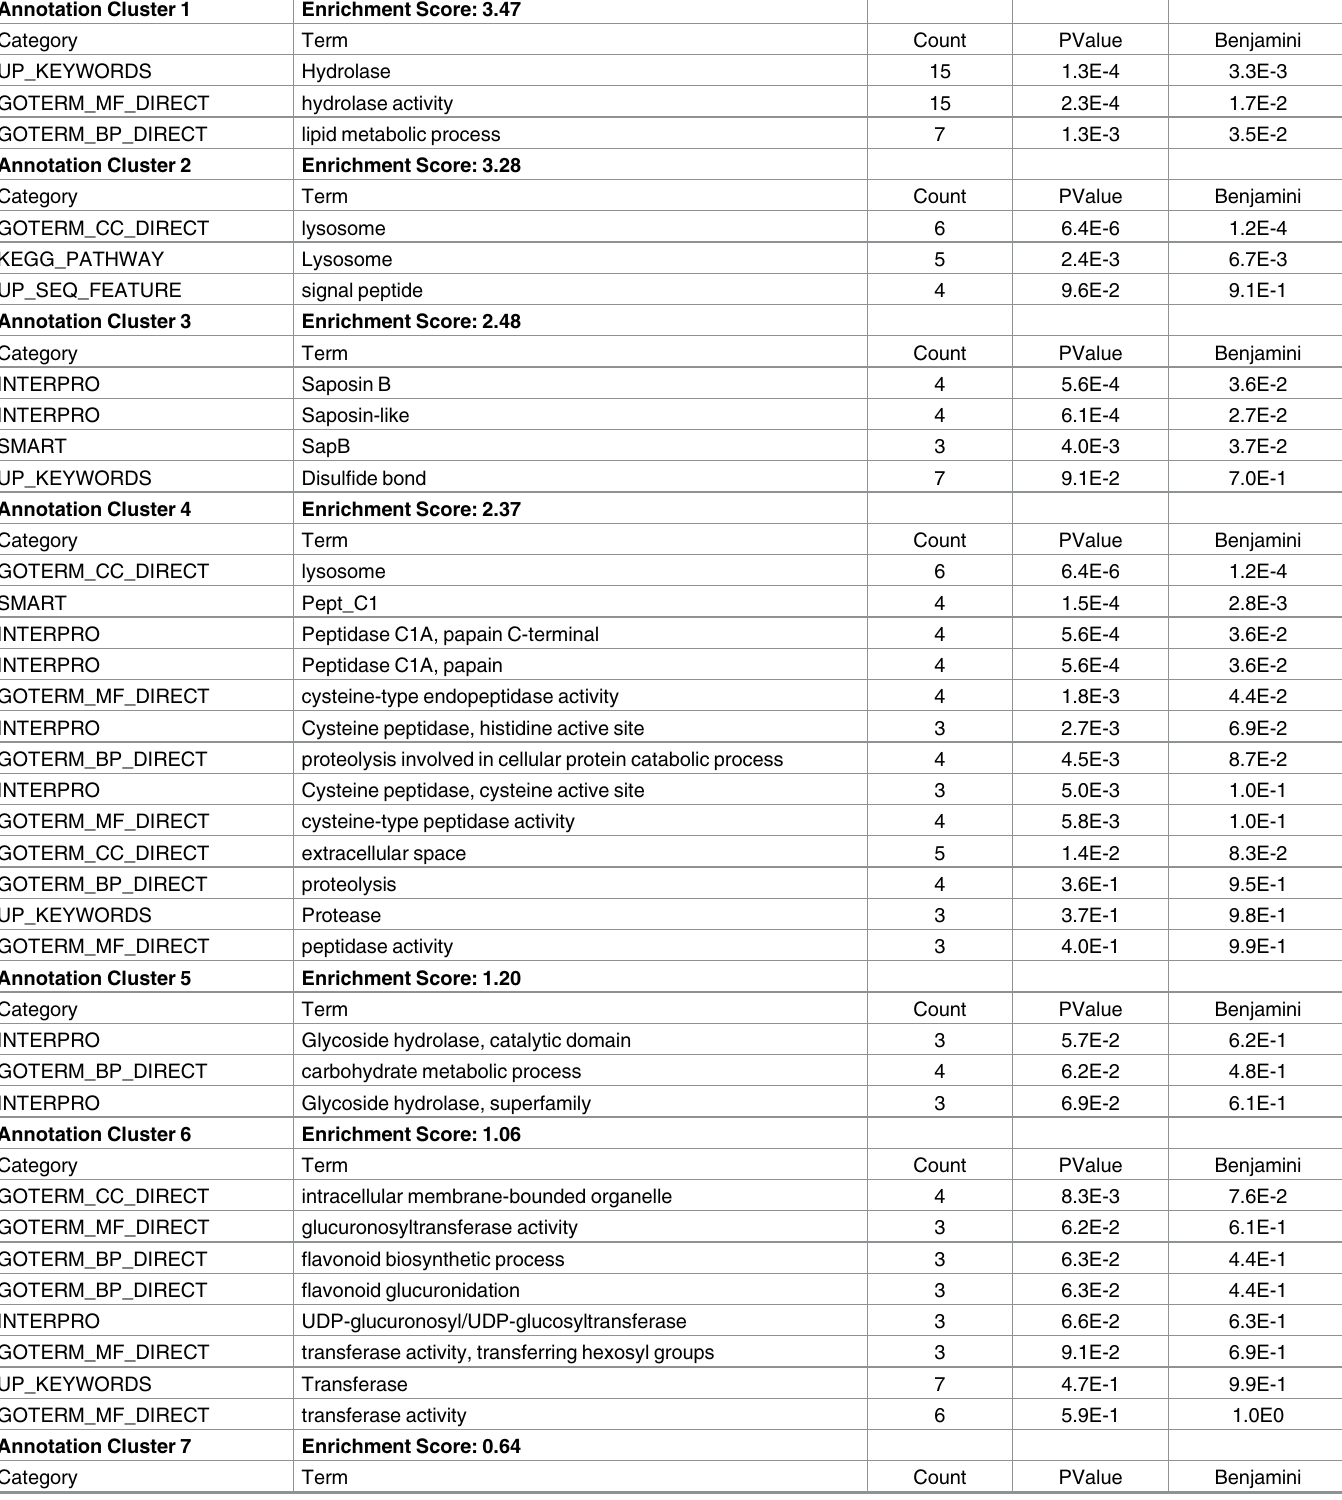
Table 2. Functional annotation clusters including up- and down-regulated genes obtained by DAVID. Annotation Cluster 1 Enrichment Score: